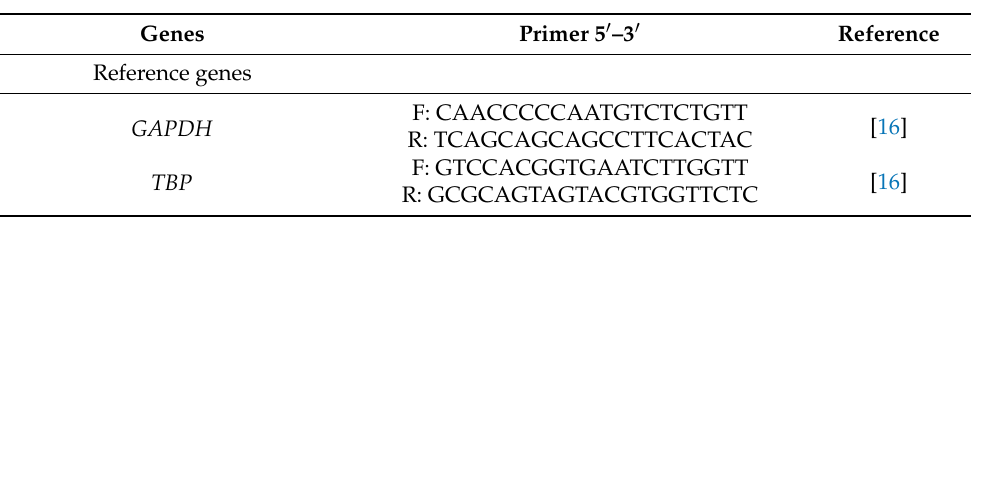
Table 2. Primer sequences of genes used in PCR